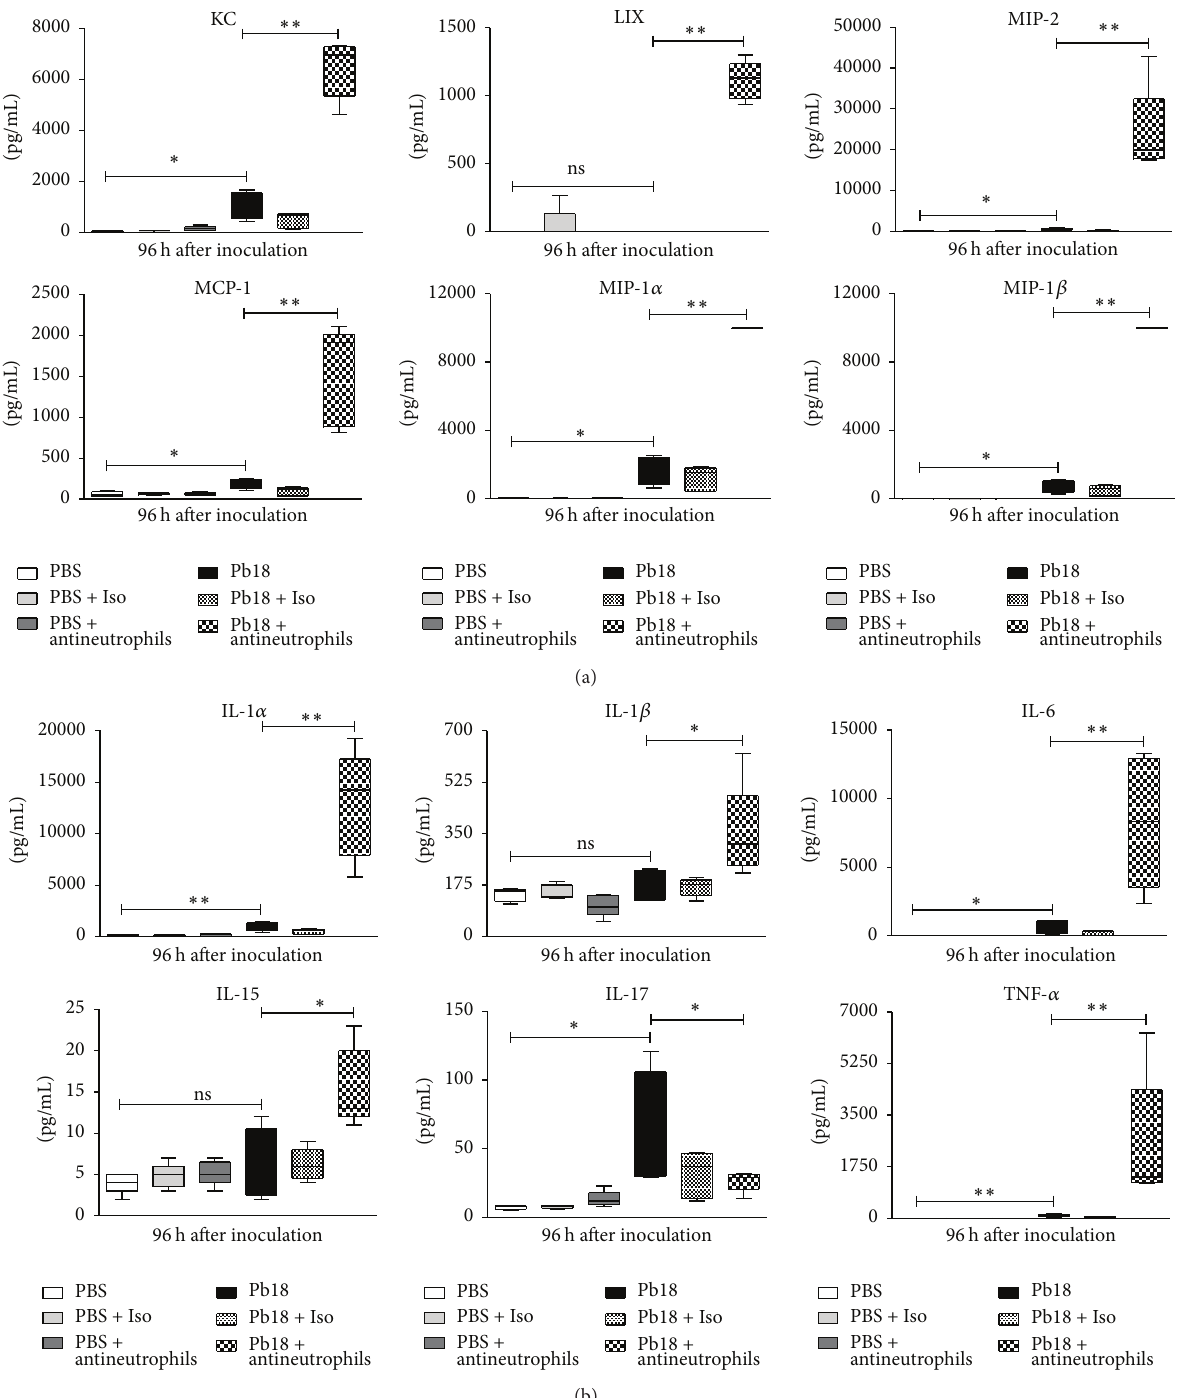
Figure 4: Depletion of neutrophils increases levels of chemokines and proinflammatory cytokines in lungs of mice infected with P. brasiliensis during the early stages of infection . BALB/c mice were challenged intranasally with 1.5 × 10 6 P. brasiliensis (Pb18) yeast cells and treated with an isotype control Ab or the anti-Ly6G mAb specific to neutrophils. Supernatants from lung homogenates of mice sacrificed at 96 h after infection were analyzed using a commercial kit and the Luminex System as described in Material and Methods. (a) chemokines (KC, LIX, MIP-2, MCP-1, MIP-1 𝛼 , and MIP-1 𝛽 ) and (b) proinflammatory cytokines (IL-1 𝛼 , IL-1 𝛽 , IL-6, IL-15, IL-17, and TNF- 𝛼 ). Data shown represent median and IQR ( 𝑛 = 4 -5 mice/group; representative of two independent experiments). ∗ 𝑃 < 0.05 and ∗∗ 𝑃 < 0.01 comparing infected- untreated mice versus control mice or comparing infected-anti-Ly6G mAb-treated mice versus infected-untreated mice. PBS, control mice; PBS + Iso, control mice treated with isotype control Ab (clone: 2A3); PBS + antineutrophils, control mice treated with anti-Ly6G mAb (clone: 1A8); Pb18, infected-untreated mice; Pb18 + Iso, infected mice treated with isotype control Ab; Pb18 + antineutrophils, infected mice treated with anti-Ly6G mAb; ns: not